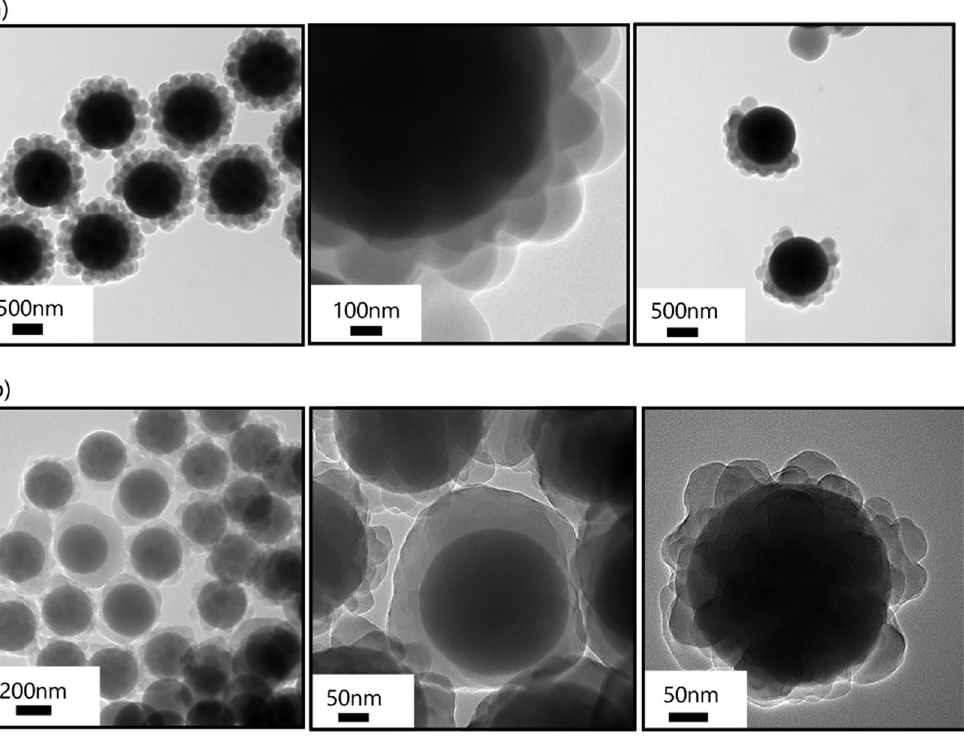
Figure 5: TEM images of the PS/SiO 2 – MAPTMS particles for ( a ) PS polymerized with no cross - linker and ( b ) PS polymerized with a cross - linker DVB.